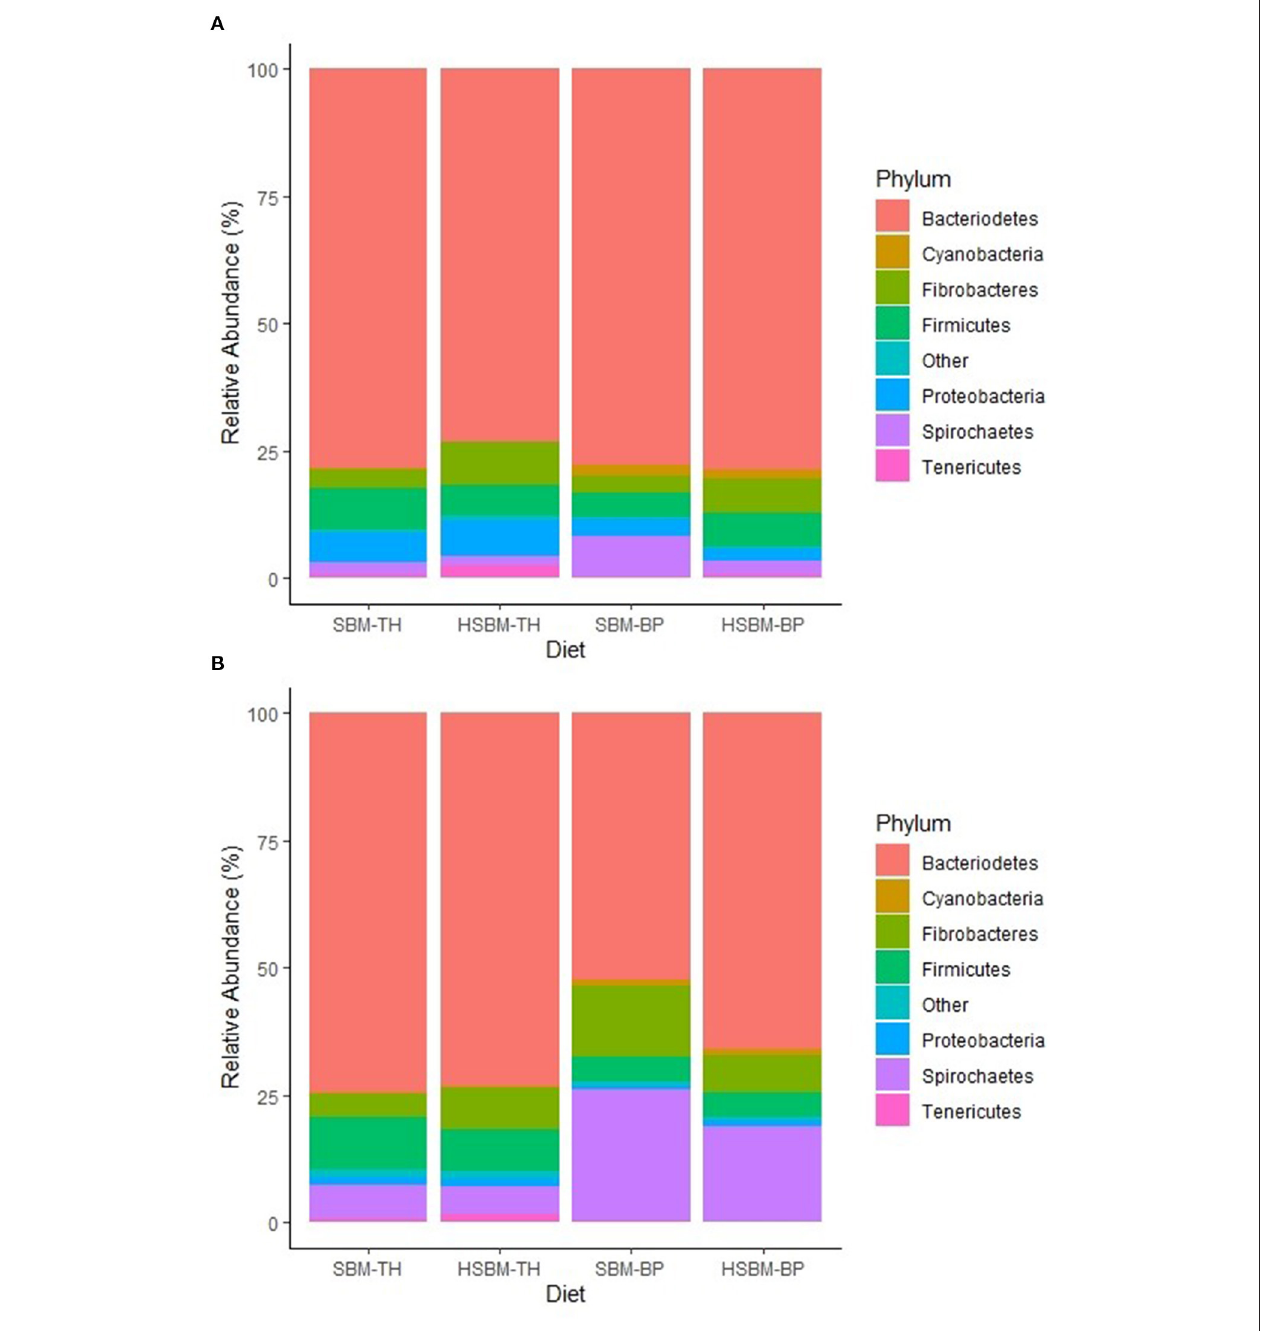
FIGURE 1 | (A) Phylum-level composition of bacteria identified in the rumen fluid fraction as differentiated by diet. The category “Other” is comprised of taxa with relative abundances < 1.0% for all diets. (B) Phylum-level composition of bacteria identified in the rumen solid fraction as differentiated by diet. The category “Other” is comprised of taxa with relative abundances < 1.0% for all